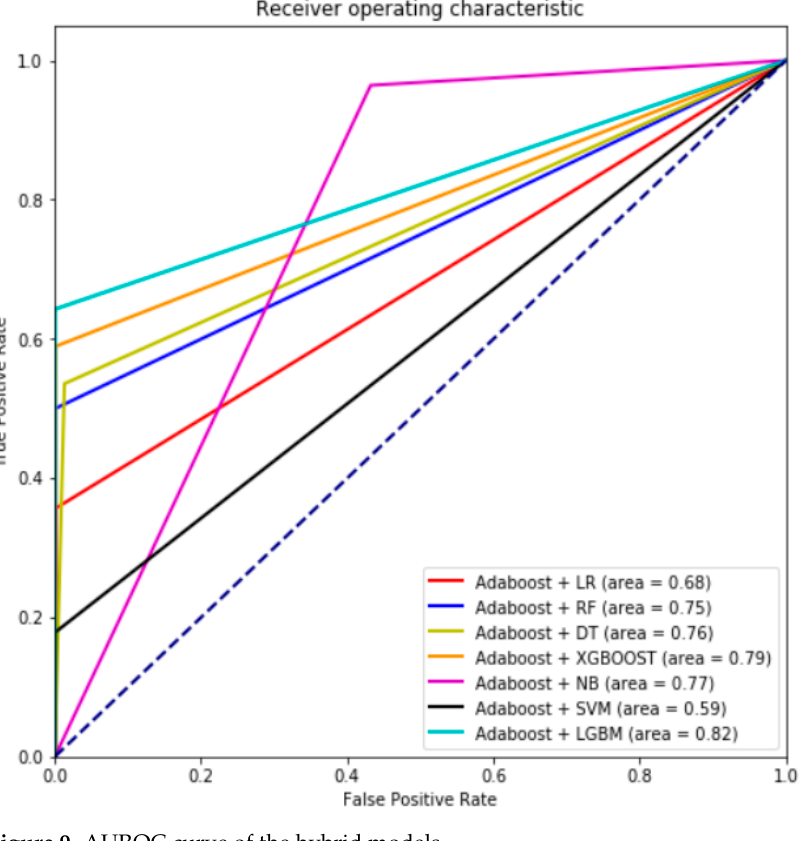
Figure 9. AUROC curve of the hybrid models.